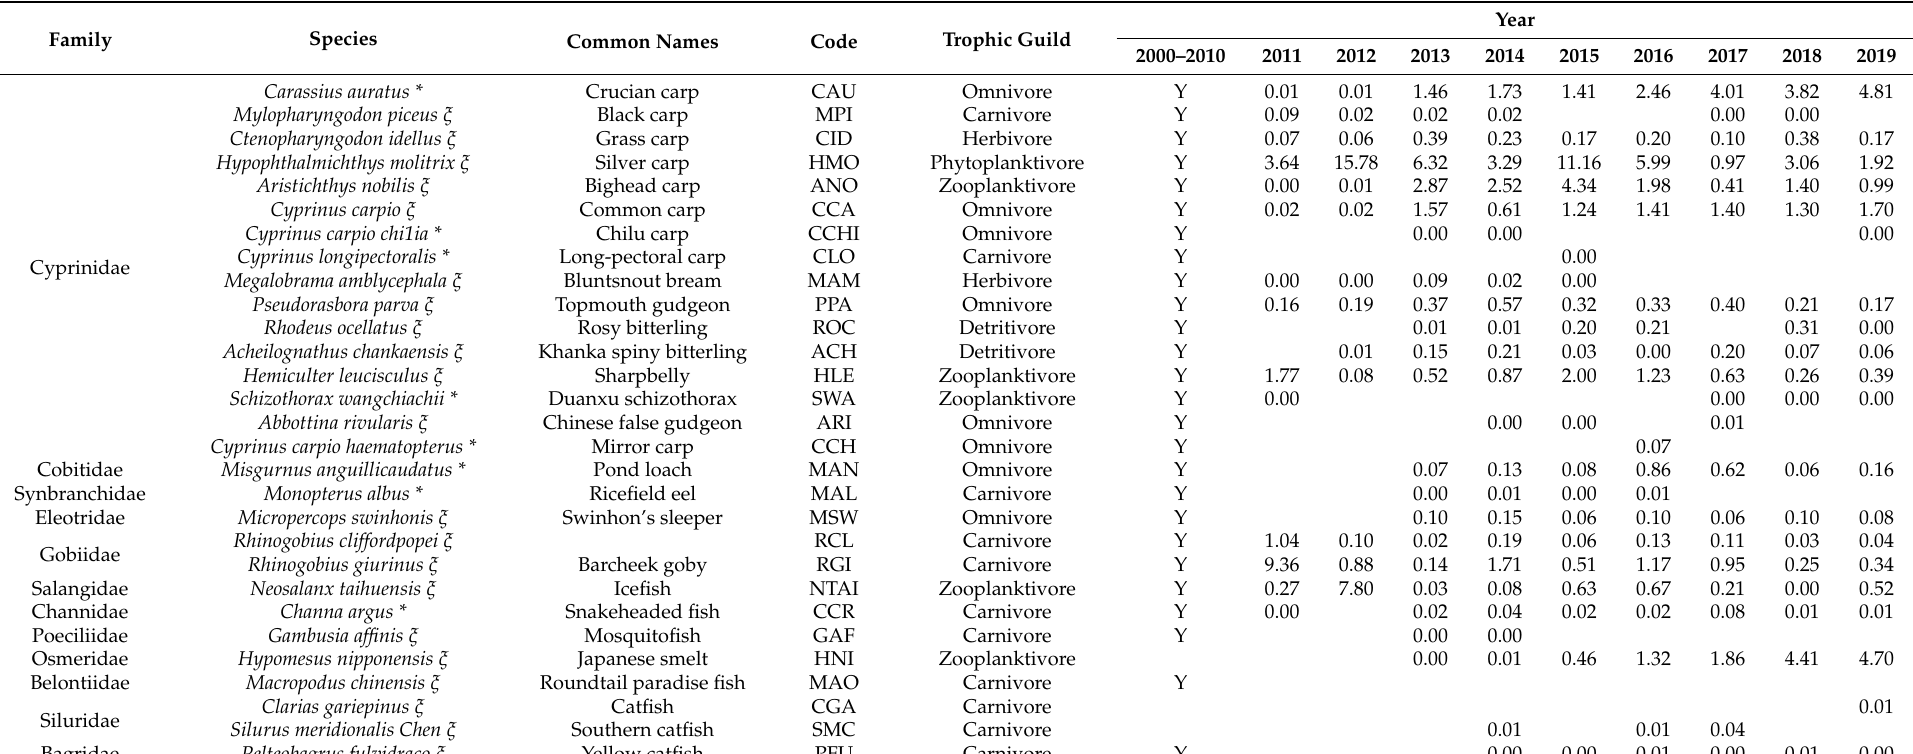
Table 2. Fish composition and CPUE in Lake Erhai from 2011 to